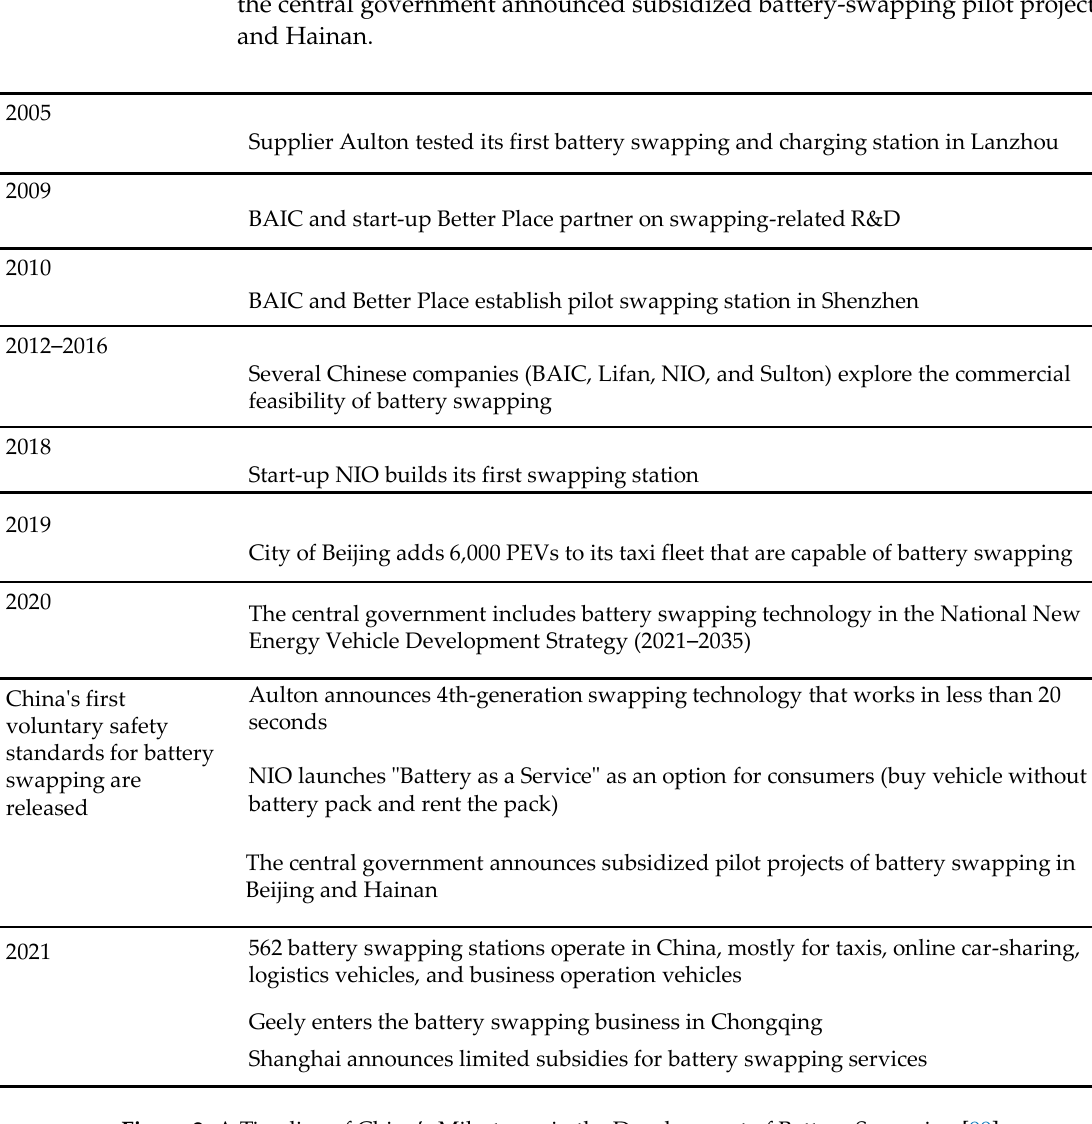
Figure 2. A Timeline of China’s Milestones in the Development of Battery Swapping [109]. NIO, a startup PEV manufacturer with a line of premium PEVs, has announced the most advanced plans to implement battery swapping for retail customers [110].